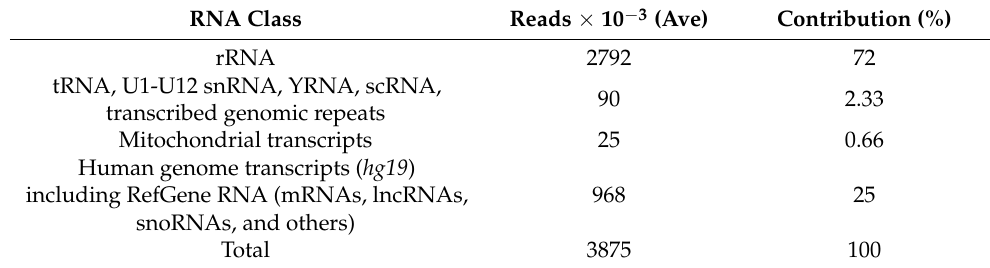
Table 3. Contribution of the main classes of human RNAs to the total set of extracellular vesicle RNAs. RNA Class Reads × 10 − 3 (Ave) Contribution (%) rRNA 2792 72 tRNA, U1-U12 snRNA, YRNA, scRNA, 90 2.33 transcribed genomic repeats Mitochondrial transcripts 25